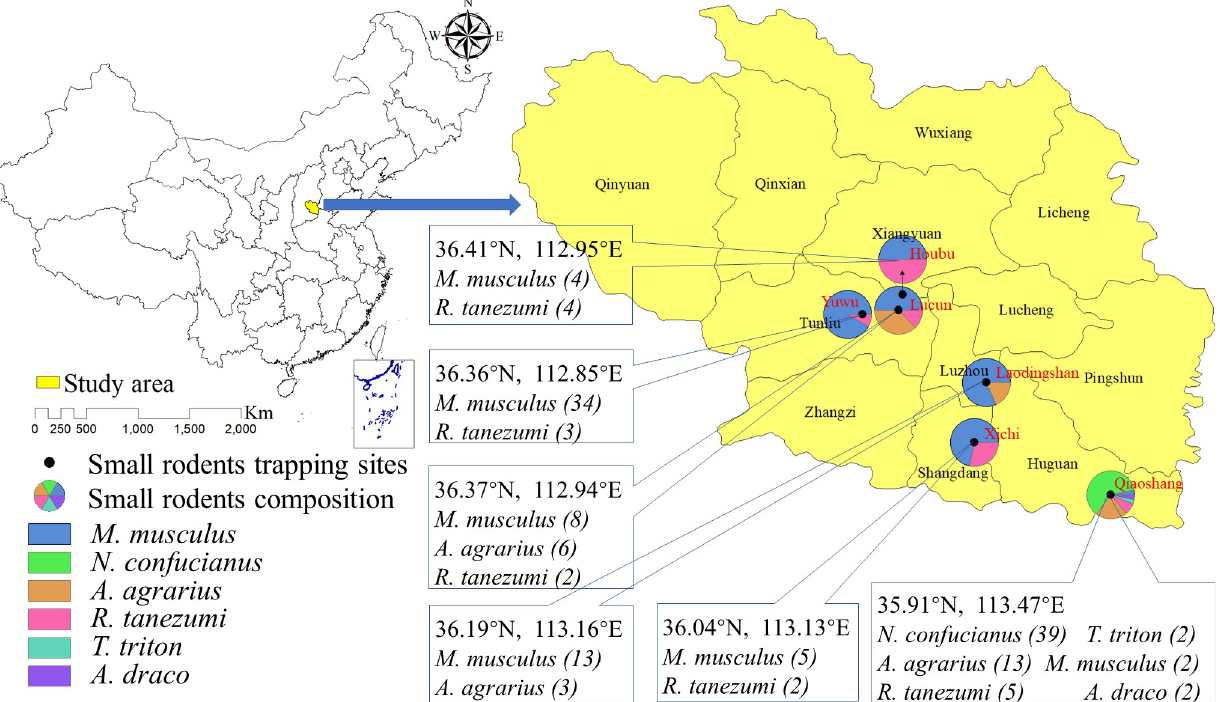
Fig 1. Geographical distribution of the trapped small rodents in the Shangdang Basin, China. The map was prepared in ArcGIS 10.2.2 using political boundaries from the National Geomatics Center of China (http://www.ngcc.cn/ngcc) for illustrative purposes only, these data are available free of charge.